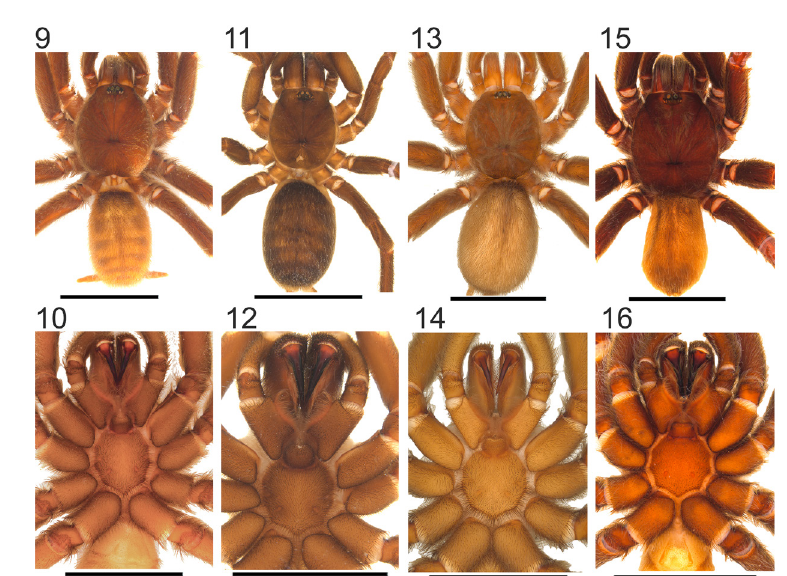
Figs 9–16. Schismatothele spp. 9–12 . Schismatothele merida sp. nov. 9–10 . Holotype, ♂ (MZSP 28411). 9 . Dorsal view. 10 . Prosoma, ventral view. 11–12 . Paratype, ♀ (MZSP 28412). 11 . Dorsal view. 12 . Prosoma, ventral view. – 13–14 . Schismatothele moonenorum sp. nov., holotype, ♂ (IBSP 168510). 13 . Dorsal view. 14 . Prosoma, ventral view. – 15–16 . Schismatothele quimbaya sp. nov., holotype, ♂ (MZSP 47524). 15 . Dorsal view. 16 . Prosoma, ventral view. Scale bars = 10 mm.